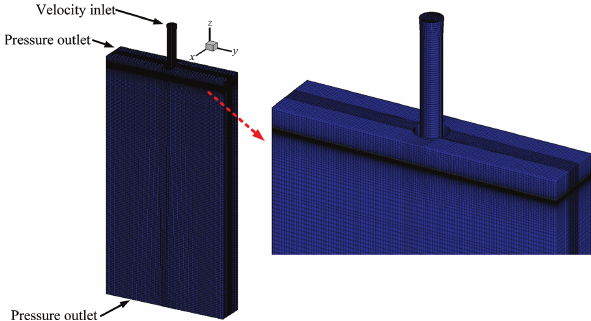
Figure 3: Grids of the domain and the closed view of the oil-water interface.